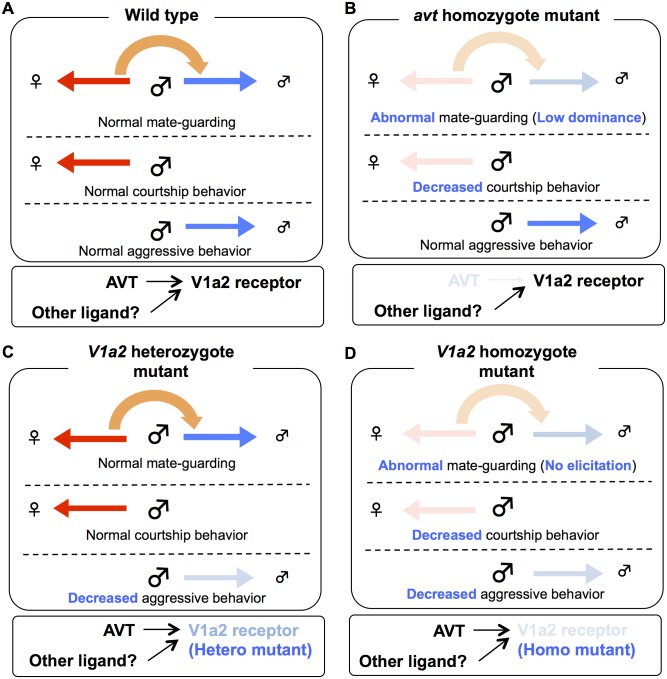
Possible model of AVT system in mate-guarding, aggressive and courtship behaviors.(A) Mate-guarding requires two different types of motivation: sexual motivation toward the opposite sex and competitive motivation toward the same sex, while courtship and aggressive behaviors require social motivation to either the opposite (red arrow) or same (blue arrow) sexes. When mate-guarding emerges in a triadic relationship, the presence of a potential mating partner may engage competitive motivation toward rival males via AVT system, leading to male-male competition (orange arrow). (B) The homozygote avt mutant males exhibited fewer courtship displays than wild-type males (Fig. 4B), whereas the mutant males exhibited normal aggression (Fig. 4A). Thus avt mutants normally have sexual motivation, but not competitive motivation toward the same sex. Decreased sexual motivation toward the opposite sex may cause low dominance of male-male competition in mate-guarding. avt was required just for dominance of mate-guarding. avt was not required for either normal aggressive behaviors or elicitation of mate-guarding, suggesting the presence of redundant system activating V1a2 receptor. (C) The heterozygote V1a2 mutant males exhibited normal courtship displays (Fig. 4B), whereas they exhibited low aggression (Fig. 4A). Thus heterozygote V1a2 mutants normally have competitive motivation, but not sexual motivation toward the opposite sex. Decreased competitive motivation towards the same sex has no effect on male-male competition in mate-guarding, because sexual motivation may dominantly drive the motivation for mate-guarding. The single functional V1a2 allele may not produce enough of a gene product, leading to attenuated aggression. (D) The homozygote V1a2 mutant males exhibited decreased courtship displays and low aggression (Figs. 4A and 4B). Thus homozygote V1a2 mutants did not normally have social motivation to either the same sex or opposite sex. V1a2 was required for elicitation of mate-guarding (Fig. 3C).